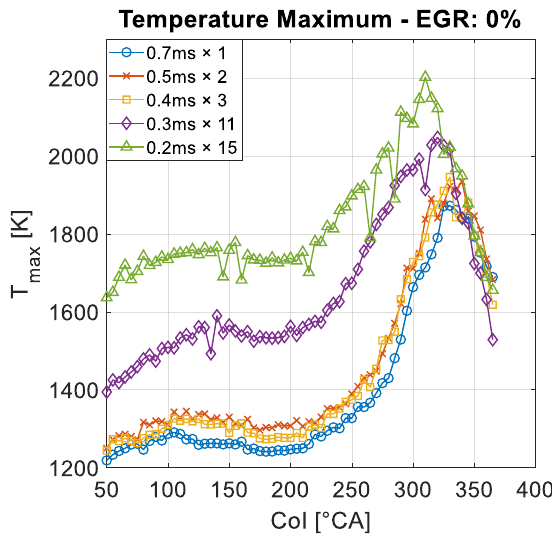
Figure 8. The temperature maxima of the investigated structures with the same dose in the function of CoI without EGR.